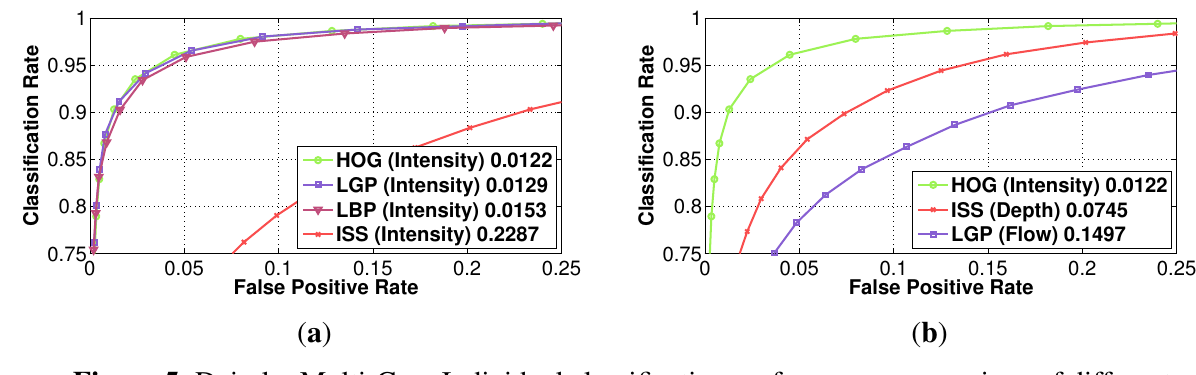
Figure 5. Daimler Multi-Cue: Individual classification performance comparison of different features on: ( a ) the intensity; ( b ) the best feature for each modality. The reference point is considered the false positive rate obtained for a classification rate of